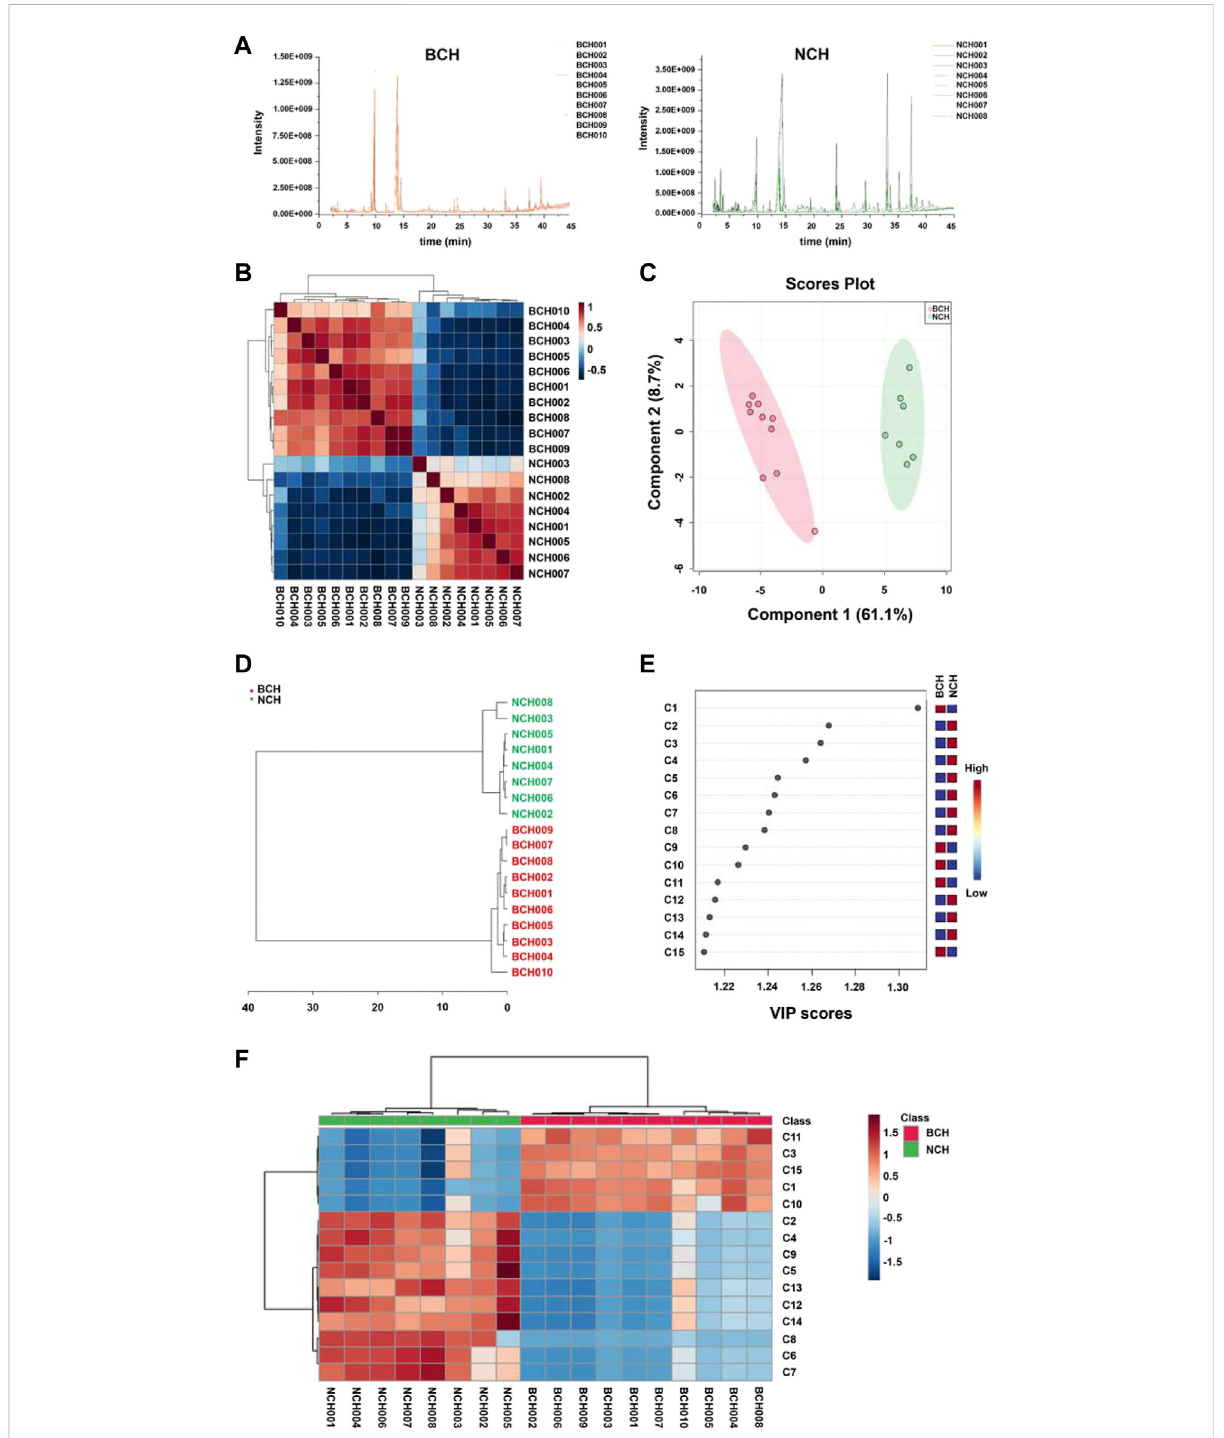
Chemometricanalysisfor speciesdiscrimination ofBCHandNCH. (A) TheGC-MSchromatogramsofBCH (BCH001-010)and NCH(NCH001- 008); (B) the SRCCA visualization for the discrepancy between BCH and NCH; (C) the PLS-DA analysis of BCH and NCH; (D) the HCA discrimination of BCH and NCH; (E) the top 15 features ranked by VIP values; and (F) Hierarchical clustering Heatmap of top 15 features ranked by t -test value. The colored boxes on the right indicated the relative concentrations of the corresponding metabolite in each group under study. C1 , tricosanoic acid; C2 , dodecenyl succinic anhydride; C3 , dodecanoic acid; C4 , lauryl acetate; C5 , 1-dodecanol; C6 , mandenol; C7 , isopropyl linoleate; C8 , octadecyl palmitate; C9 , docosanoic acid; C10 , tetracosanoic acid; C11 , methyl 5,8,11-heptadecatriynoate; C12 , undecanoic acid; C13 , tridecane; C14 , trans-3-octadecene; and C15 , β